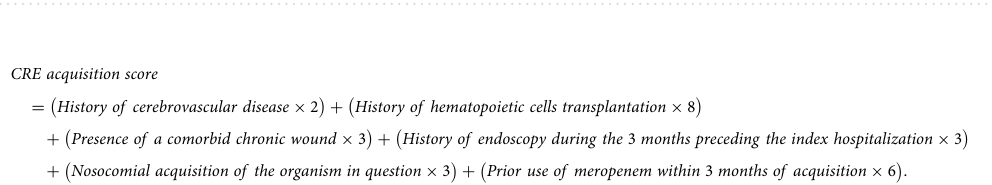
Table 2. Bivariate comparison between cases and controls regarding the type of isolated species and distribution of isolation site.